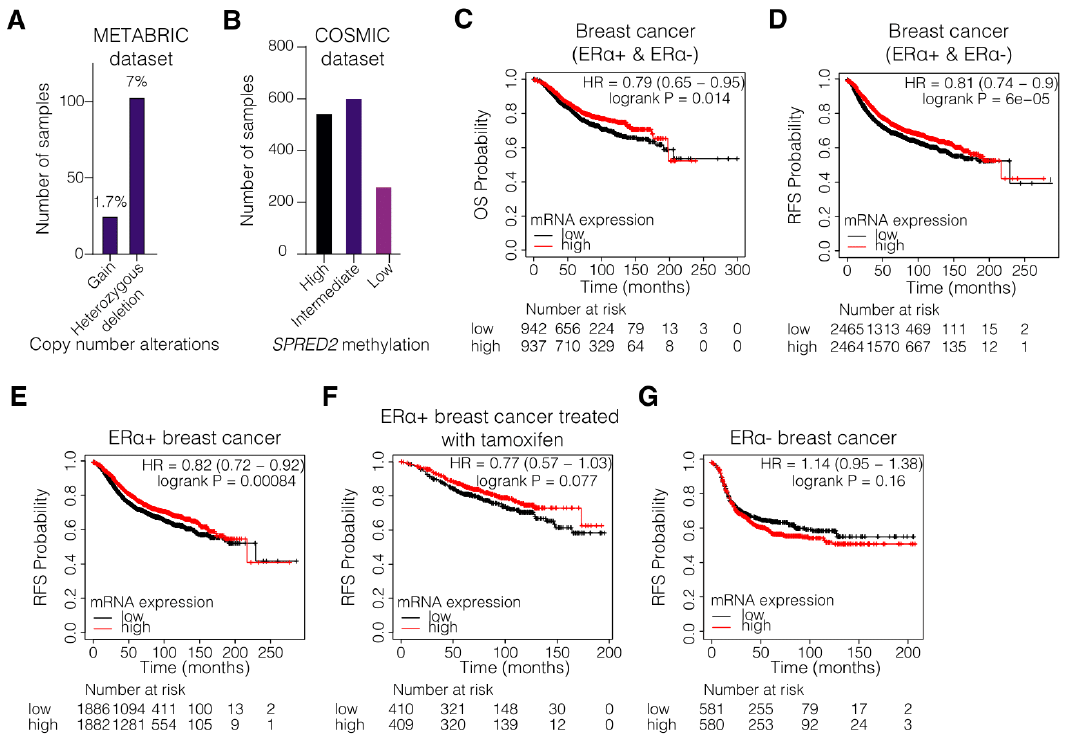
Figure 1. Low SPRED2 gene expression correlates with poor survival of patients with breast tumors. ( A ) METABRIC dataset analysis showing the mutation types of SPRED2 in ERα+ breast cancer patients. ( B ) COSMIC dataset analysis showing the SPRED2 methylation status in breast cancer patients. Of the total number of 1414 samples in this dataset, all but one of the 545 samples are hypermethylated at position chr2:65313277 (located in the 3′UTR and coinciding with a CTCF binding site). ( C – G ) Kaplan–Meier plots for the overall survival (OS) and the relapse free survival (RFS) of all (C,D), ER α + ( E ), tamoxifen-treated ER α + ( F ), and ER α – ( G ) breast cancer patients, classified as tumors expressing high levels (red line) and low levels (black line) of SPRED2